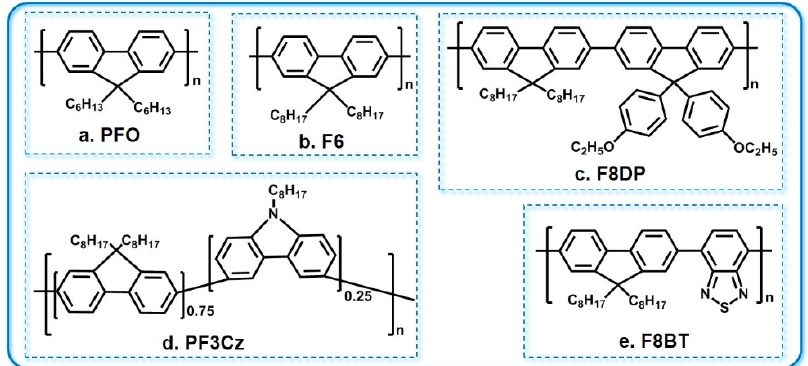
Figure 9. The chemical structure of some PF derivatives. ( a ) PFO: poly(9,9-dioctylfluorene); ( b ) F6: